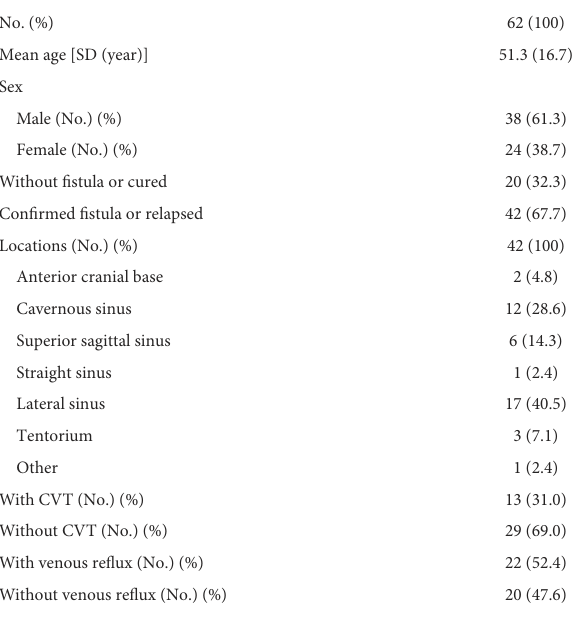
TABLE 1 Demographics, locations and